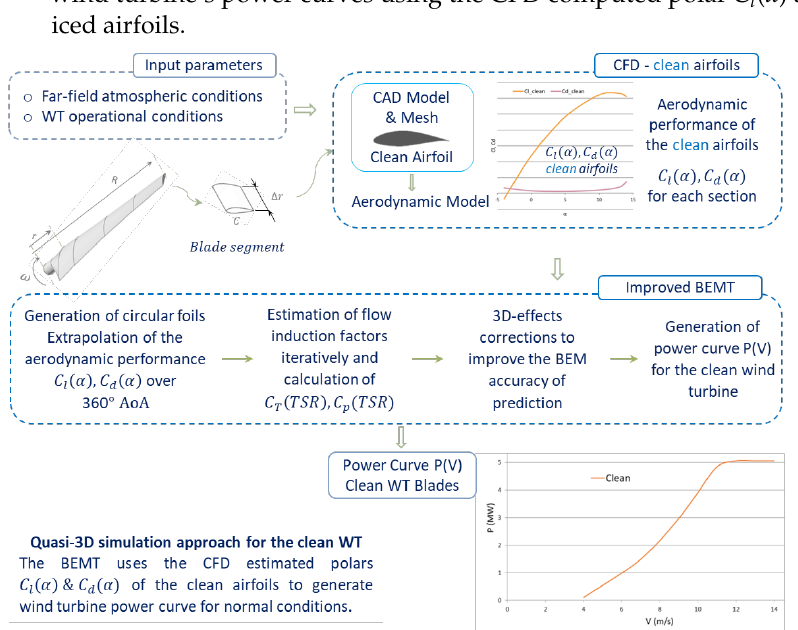
Figure 7. Generation of power curve P(V) for the clean (no-ice) wind turbine. @Fahed Martini.